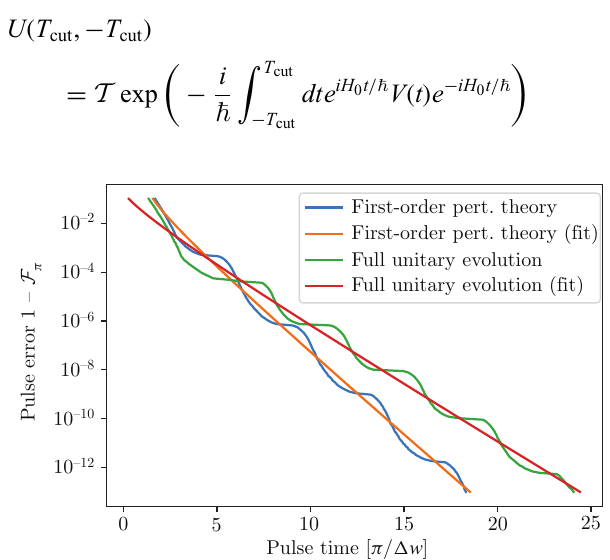
FIG. 8. The maximal error of an optimized π pulse with trun- cated Gaussian envelope as a function of the pulse time T π = 2 T cut is plotted for a fixed dipolar coupling (cid:2)ω . The error decreases exponentially with the pulse time on top of which there are Rabi-like oscillations with period 4 π/(cid:2)ω . The fits to the numerically optimized pulse times are of the form